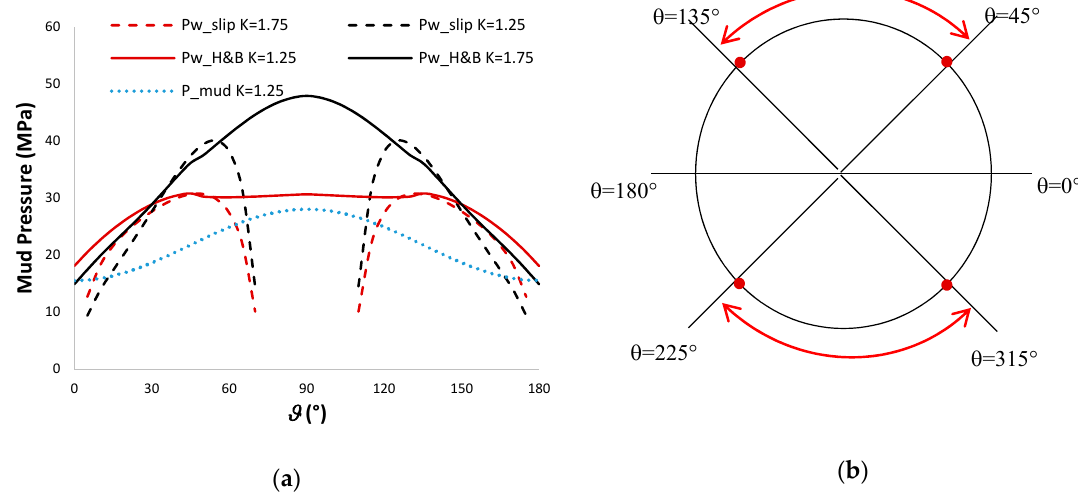
Figure 15. ( a ) Mud pressures calculated at δ = 90° with the weakness plane model and Hoek and Brown criterion, when K = σ MAX / σ min = 1.25 K = σ MAX / σ min = 1.75 ( σ min = 40 MPa, P f = 35 MPa) for the Artificial rock. Comparison with the mud pressure (P_mud) calculated with the Mohr Coulomb criterion when K = 1.25. ( b ) Extent of the instability predicted by the weakness plane model (red circles) and the Hoek and Brown criterion (red arcs), when K = σ MAX / σ min = 1.25. The weakness plane model predicts local instability. The Hoek and Brown criterion predicts that half of the circumference of the wellbore is unstable.